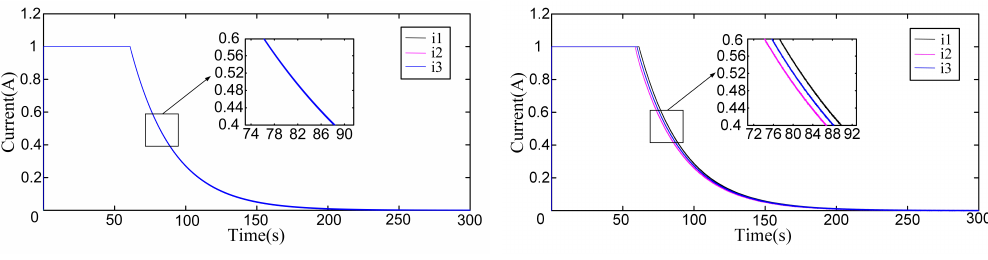
( a ) The three charging modules’ current of the cooperative charging